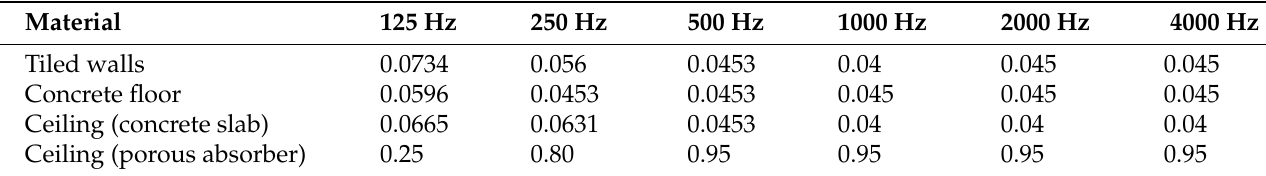
Table 1. Absorption parameters used in the simulations. The values for the porous absorbers are table values for the random-incidence absorption coefficient, taken from the manufacturer of the product. For bands centered on 125–500 Hz, the absorption parameters are random-incidence absorption coefficients estimated from the conductances used in the Meissner calculations. The remaining values have been estimated by simultaneous tuning for all algorithms, trying to emulate the